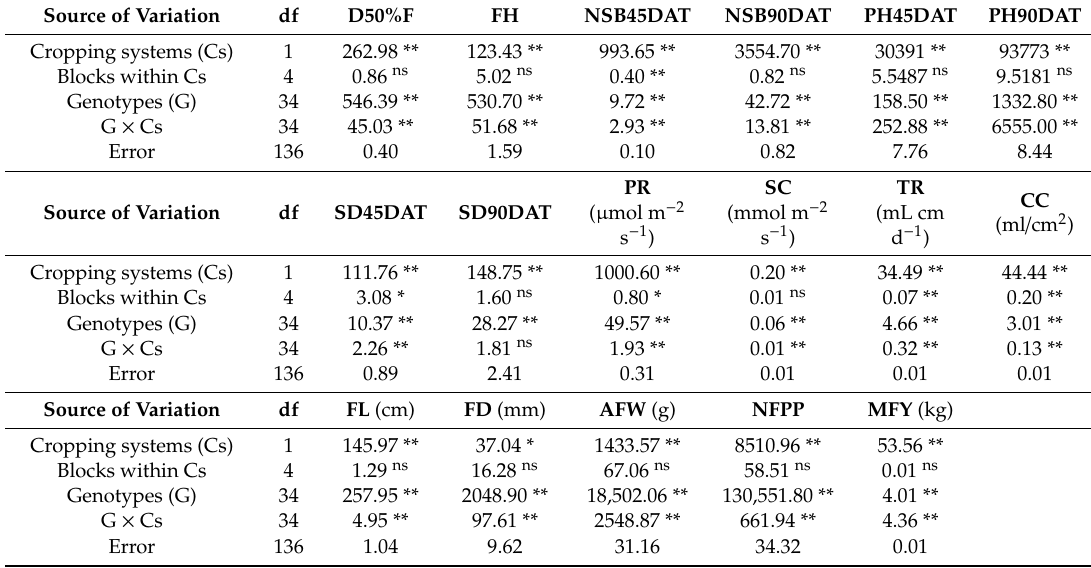
Table 1. Analysis of variance for earliness and growth characters of the grafted, self-grafted and non-grafted eggplants genotypes studied across the cropping